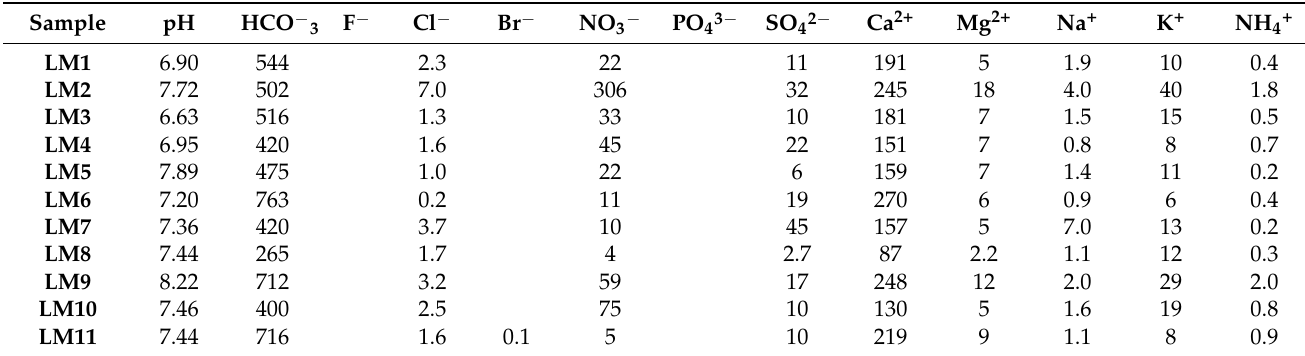
Table 5. pH values and concentrations of main cations and anions (mg · L − 1 ) in the CO 2 -saturated MillQ water eluate